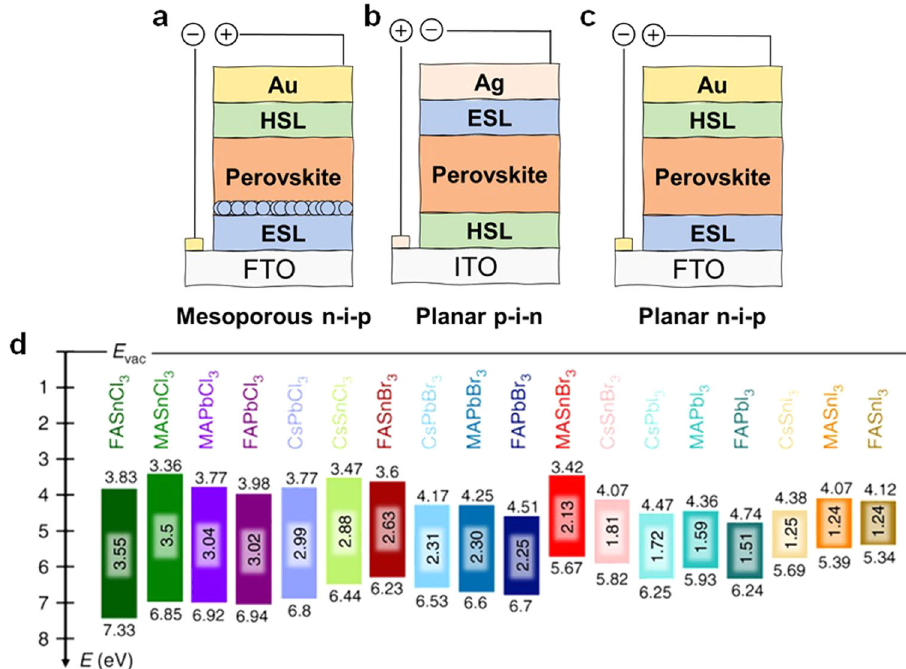
Fig. 4 Illustration of the different types of architectures of the perovskite devices and energy level diagrams of different compositions of perovskites. PSCs with a mesoporous n-i-p b planar p-i-n and c planar n-i-p device structures. d Schematic band diagrams of tin perovskites compared to lead perovskites. (Fig. 4 a – c adapted with permission from ref. 135 . Figure 4d reprinted with permission from ref. 53 , Copyright 2019 Springer